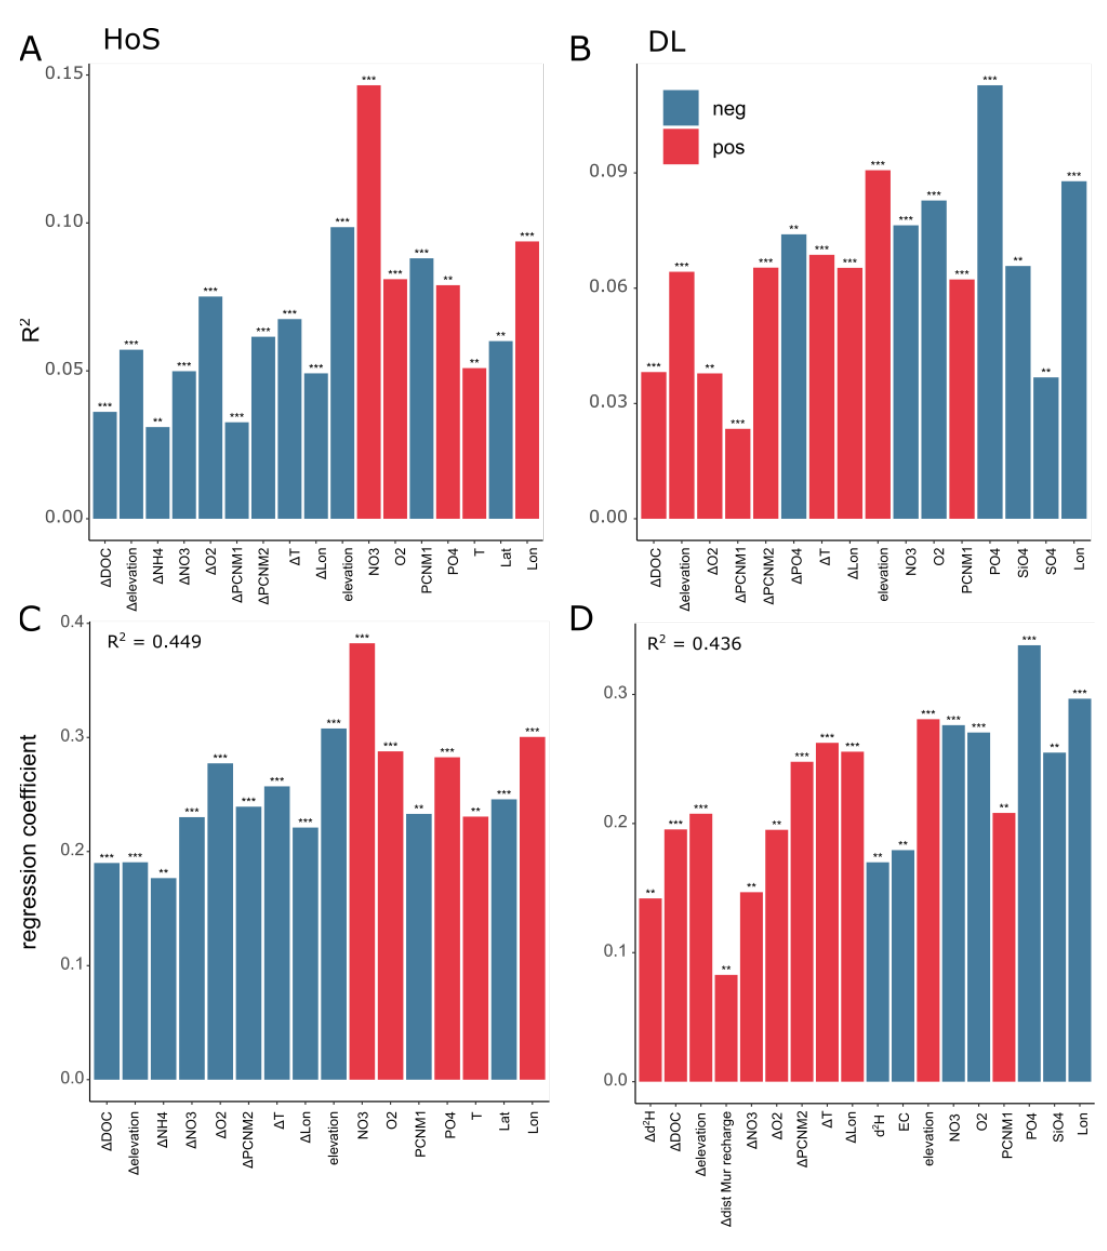
Figure 5. Correlations of environmental variables showing factors with significant correlations for HoS ( A ) and DL ( B ) based on a Mantel analysis. Multiple regression on distance matrix (MRM) for HoS ( C ) and DL ( D ) with regression coefficient on the y -axis and R 2 shown based on the model from the Mantel test, which was based on log-transformed data. Negative correlations are colored in blue, and positive are colored in red. Correlation was based on the difference ( ∆ ) or the mean of the variables between each pair of samples (*** p < 0.01; ** p < 0.05). The most important contributions of different variables were determined with an MRM. Regarding processes of HoS, again, nitrate concentrations, as well as elevation,